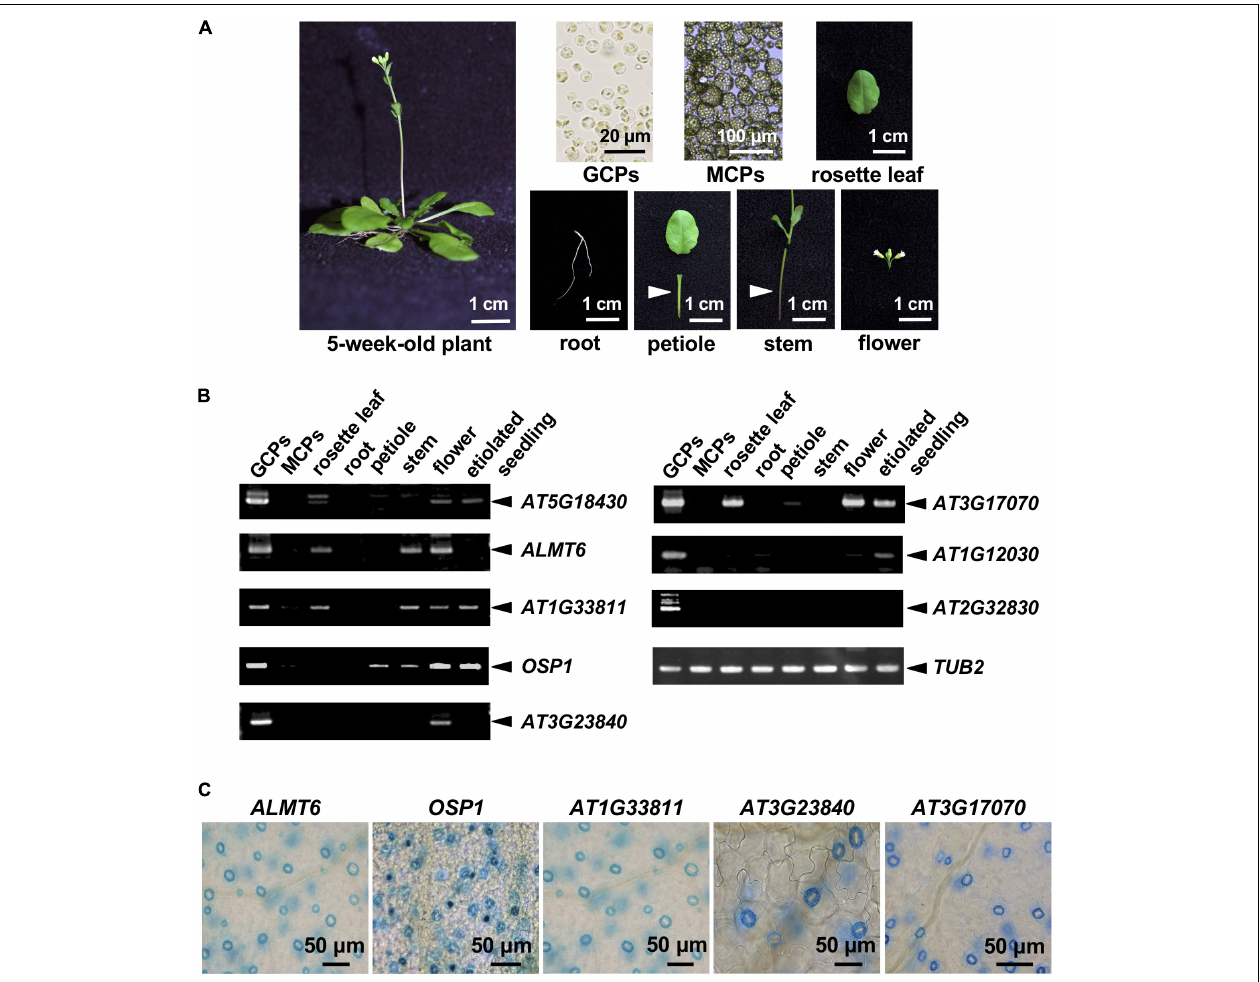
FIGURE 1 | Guard cell (GC)-preferentially expressed genes. (A) The plant organs, tissues, and cells used in the analysis. (B) GC-preferentially expressed genes as revealed by RT-PCR using the materials shown in panel (A) . (C) GC-preferentially expressed genes in GUS-reporter-bearing plants.